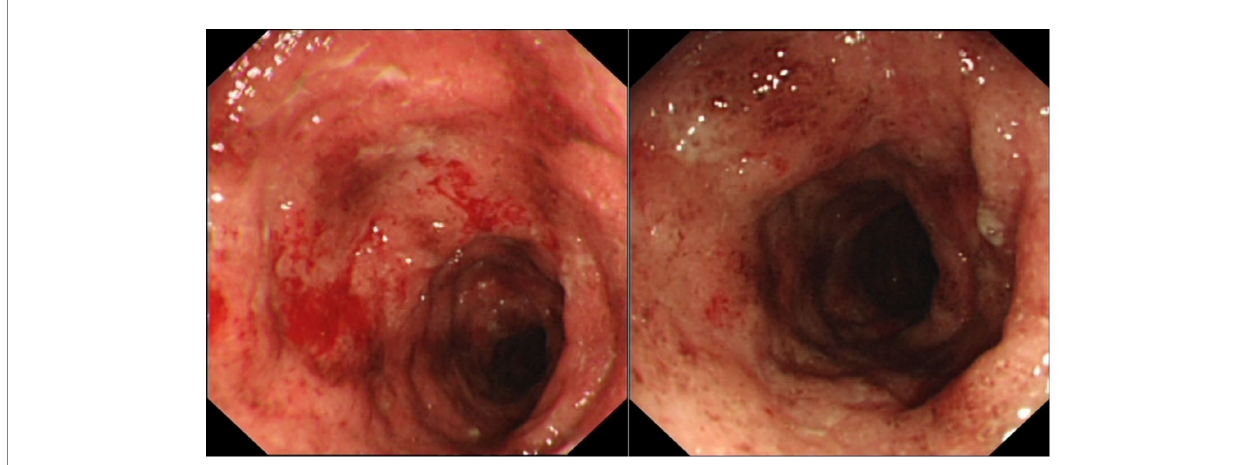
FIGURE 1 Colonoscopic images showing erythema and granularity of the examined colon mucosa with superficial exudated ulcerations, loss of normal vascular pattern and areas of spontaneous bleeding (Mayo Endoscopy Subscore